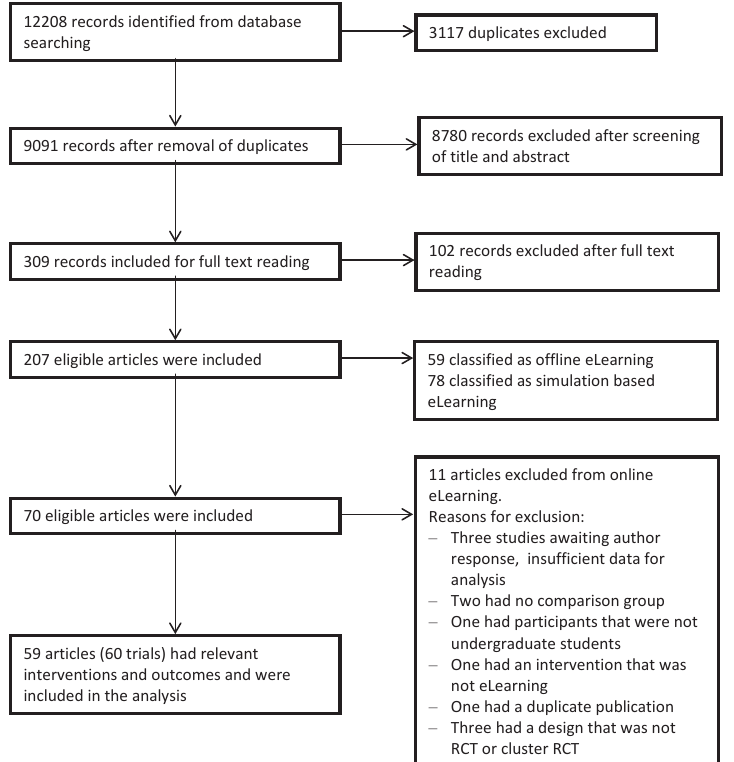
Figure 1. Flowchart of the studies included in the